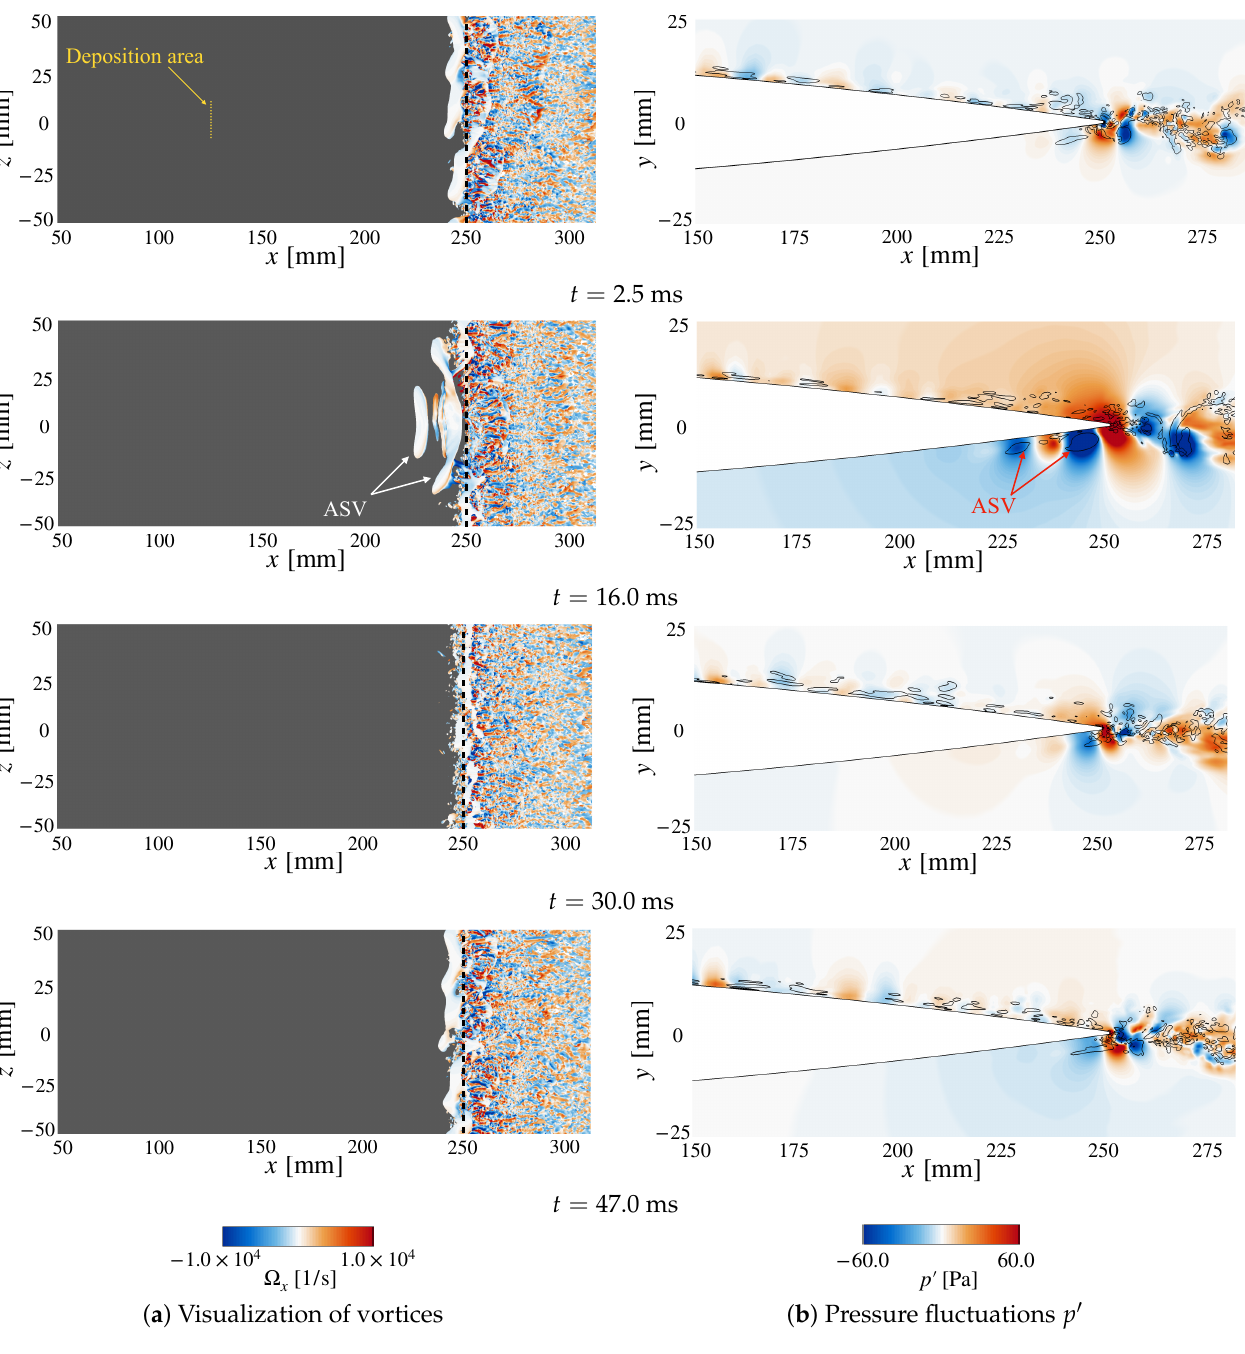
Figure 15. Time series of instantaneous flow field from t = 16.0 ms to 47.0 ms for the Narrow case. The definitions of iso-surfaces and contours are the same as in Figure 14. The figure also shows the deposition area with the yellow-dashed